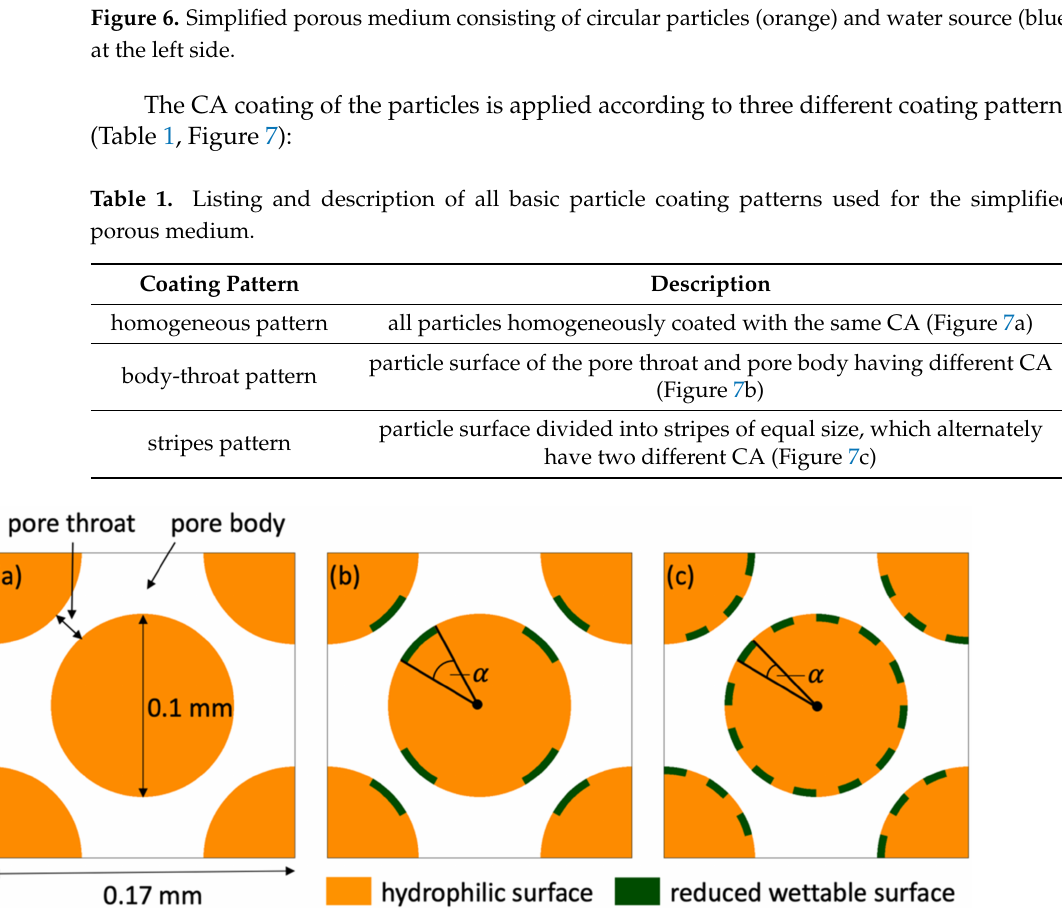
Figure 7. Coating patterns of the simplified porous medium: ( a ) homogeneous, ( b ) body-throat with a specific CA of each compartment type where the extension of the compartment with reduced wettability is defined by angle α and ( c ) stripes defined by angle α . Figure part ( b ) shows the throat-phobic coating with α = 30 ◦ and ( c ) the stripes coating with α = 15 ◦ . CA of 0 ◦ , 20 ◦ , 30 ◦ , 40 ◦ , 50 ◦ , 55 ◦ , 60 ◦ , 70 ◦ , 80 and 90 ◦ are used to investigate